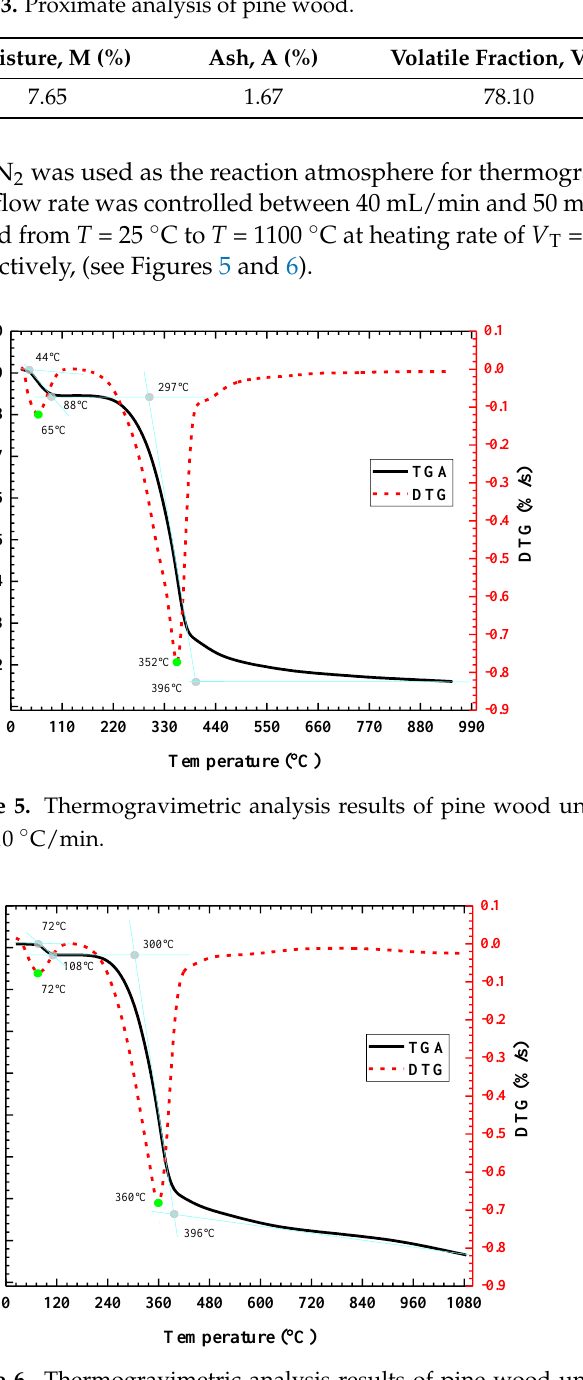
Figure 6. Thermogravimetric analysis results of pine wood under the condition of heating rate V T = 20 °C/min.